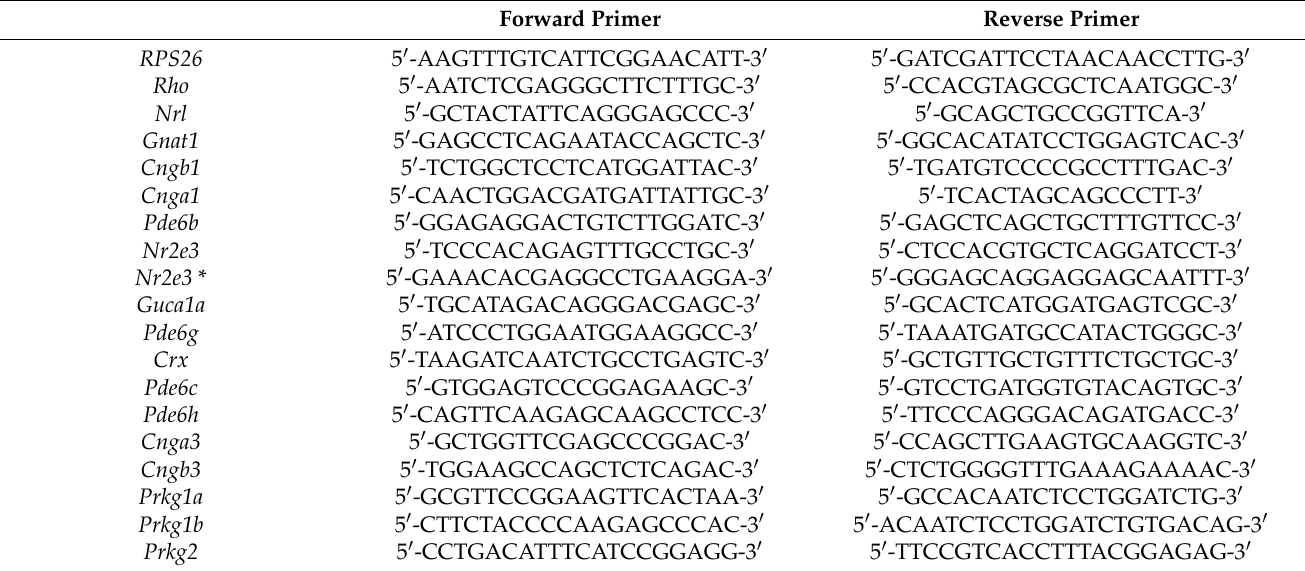
Table 1. Primers used for RT-PCR and real-time